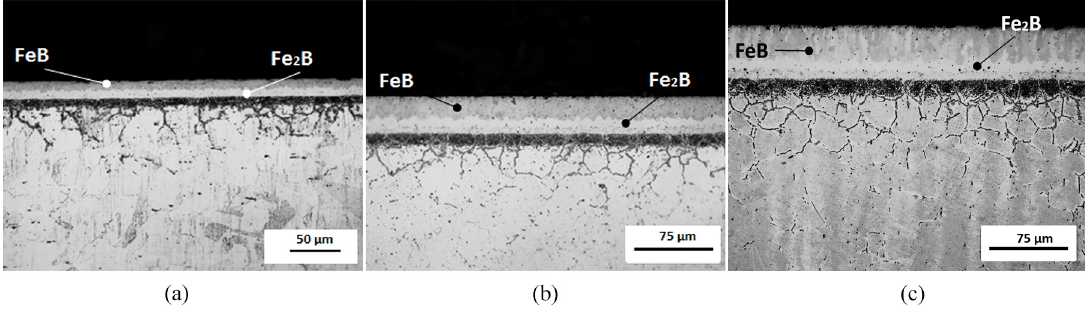
Figure 2. Micrography of boride layer formed on AISI 304 steel at 1223 K during different exposure time: (a) 2 h, (b) 6 h and (c) 10 h.